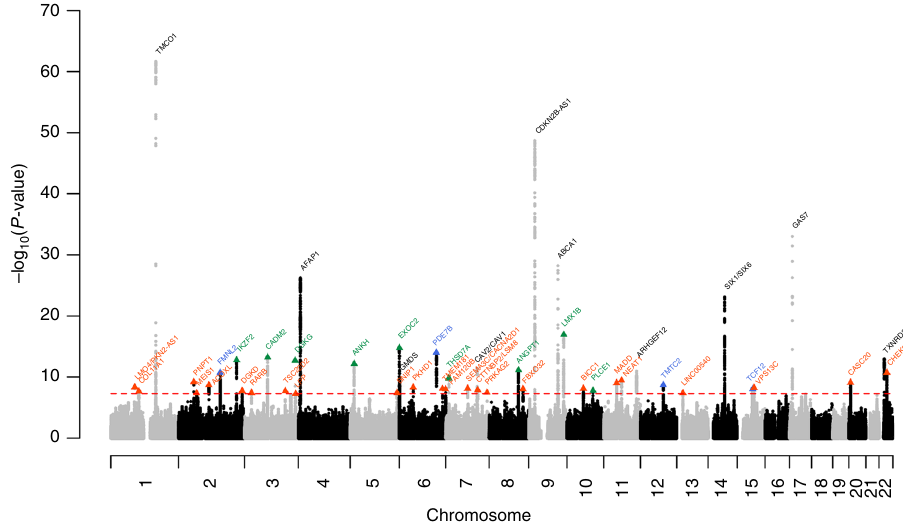
Fig. 2 Manhattan plot of the GWAS meta-analysis (GERA + UKB) for glaucoma. Association results ( – log10 P -values) are plotted for each chromosome. Names of loci and lead variants are indicated in color: previously identi fi ed loci are in black, blue triangles indicate GERA lead variants at novel loci identi fi ed in GERA, green triangles are lead UKB-identi fi ed variants at novel loci, and orange triangles are for lead GERA + UKB-identi fi ed variants at novel